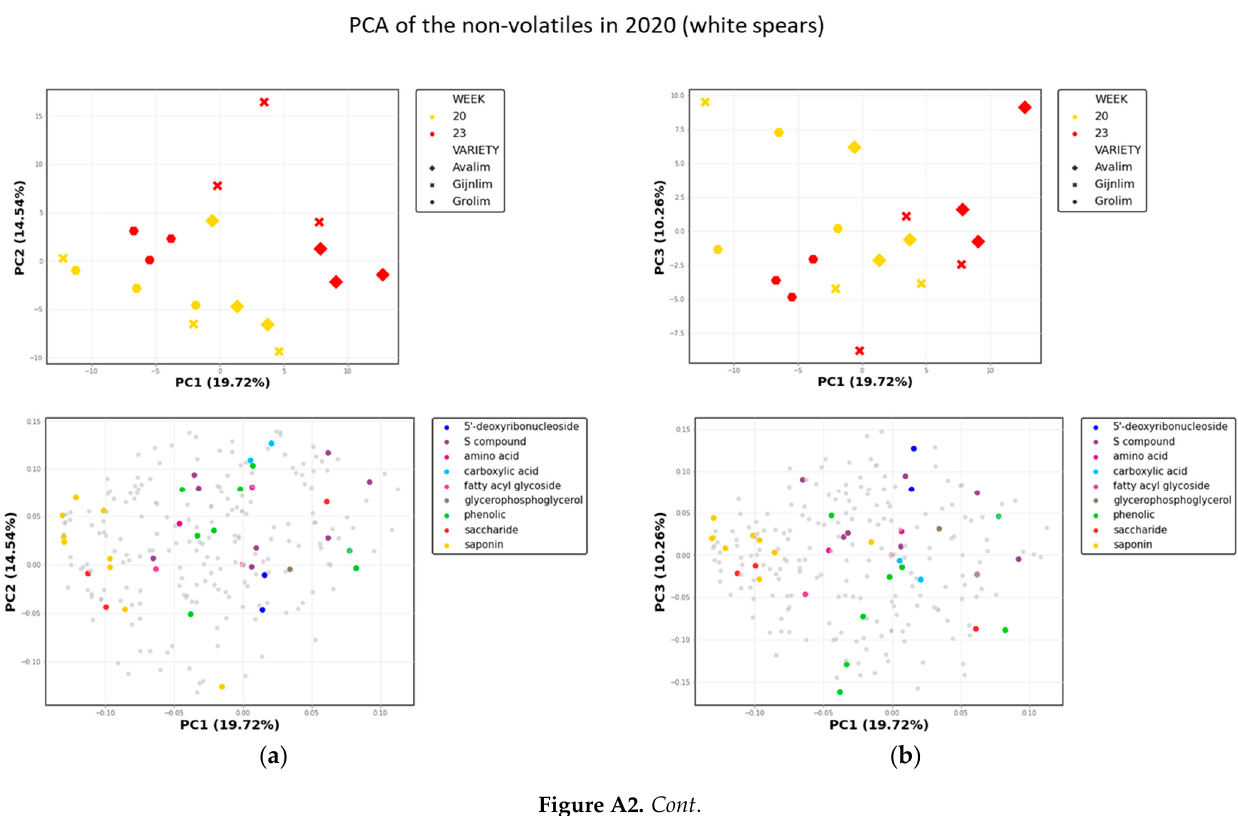
Figure A1. PCA of the volatile profiles of the white and green asparagus spears, separately, harvested in 2020; the first three PCs are given and the explained variance is shown in parentheses on the axes. In the score plots, colour indicates the calendar week of harvest, symbol shape indicates asparagus variety: ( a ) score and loadings plot of the second and third PCs of the analysis of the white varieties; ( b ) score and loadings plot of first two PCs of the analysis of the green varieties; in the loading plots, colour indicates the compound class of the identified volatiles and unidentified volatiles are coloured grey.